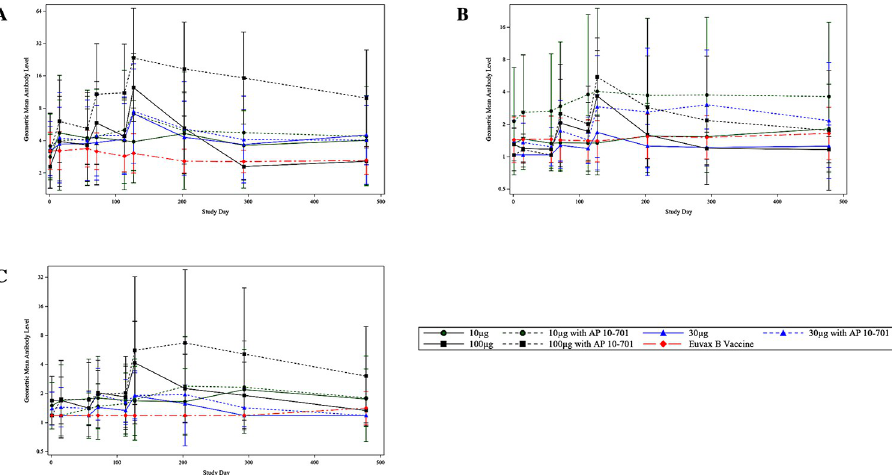
Fig 6. Geometric mean anti- Sm- TSP-2 IgG subclass responses over time by vaccine group, as measured by ELISA (Arbitrary Units): A) IgG1, B) IgG3, C) IgG4. (Per-protocol immunogenicity population). Note: Vaccinations were administered on study days 1, 57, and 113. Error bars represent 95% confidence intervals. Euvax B hepatitis B recipients were pooled across cohorts.